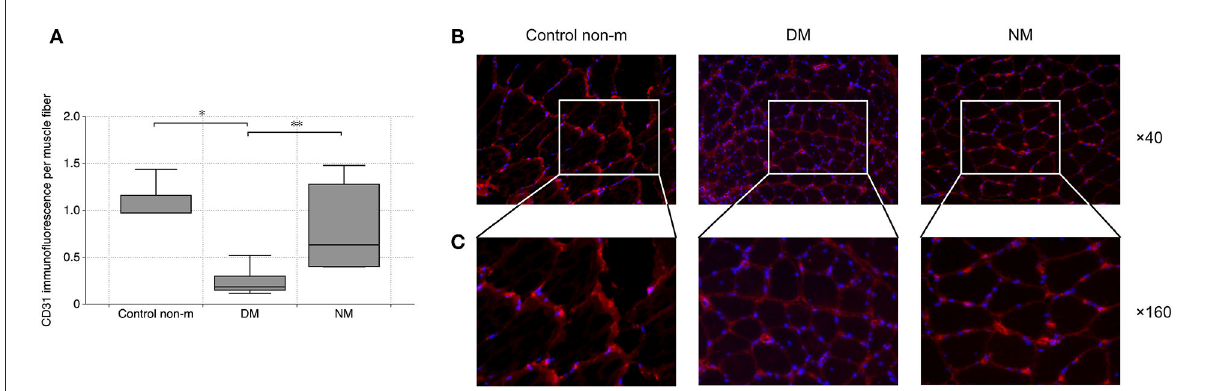
FIGURE2 Analysis of vascular density. Vascular density was evaluated by quantification of CD31 immunofluorescence per muscle fiber. The analysis (A) showed a significantly lower vascular density in DM as compared to the Control non-m group. In addition, DM patients displayed lower vascular density in comparison with NM. Fluorescence images (B) show representative sections after CD31 staining (CD31 (red), magnification × 40). Panel C shows magnified areas from each group ( × 160), and they illustrate the loss of CD31 in DM as compared to Control non-m and to NM more in detail. The following numbers of samples were analyzed per group: Control non-m: n = 6; DM: n = 16; NM: n = 6 (Control non-m: non-myopathic control; magnification in all images × 40; * , p-values < 0.05; ** , p-value <